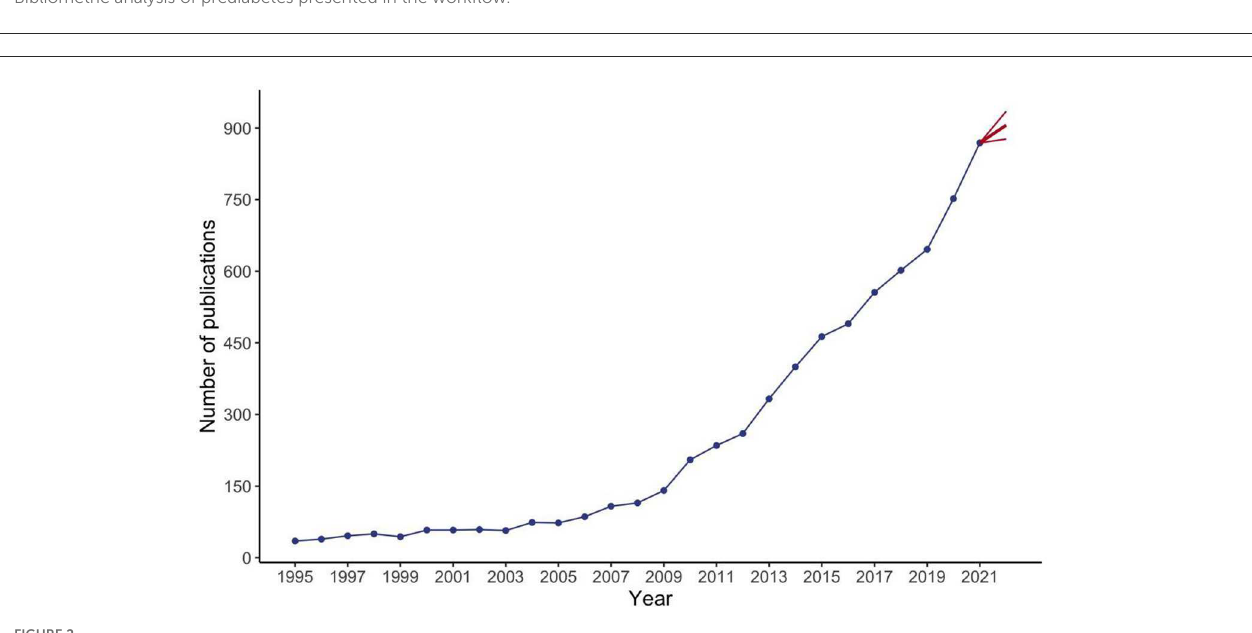
FIGURE2 Growth trend and prediction of